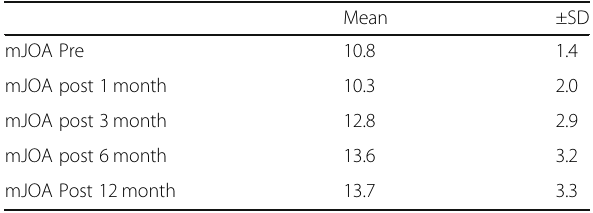
Table 4 Comparison between preoperative and postoperative mJOA score mean values at different follow-up intervals among